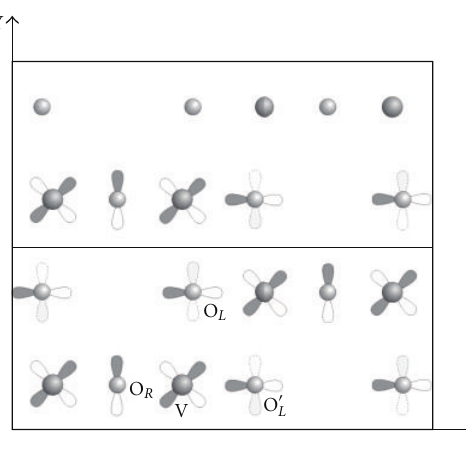
Figure 28: Schematic representation of the orbitals used for the extended TB model. O (cid:2) p y orbitals included implicitly via renor- L malization of the other hopping terms are plotted by dashed line